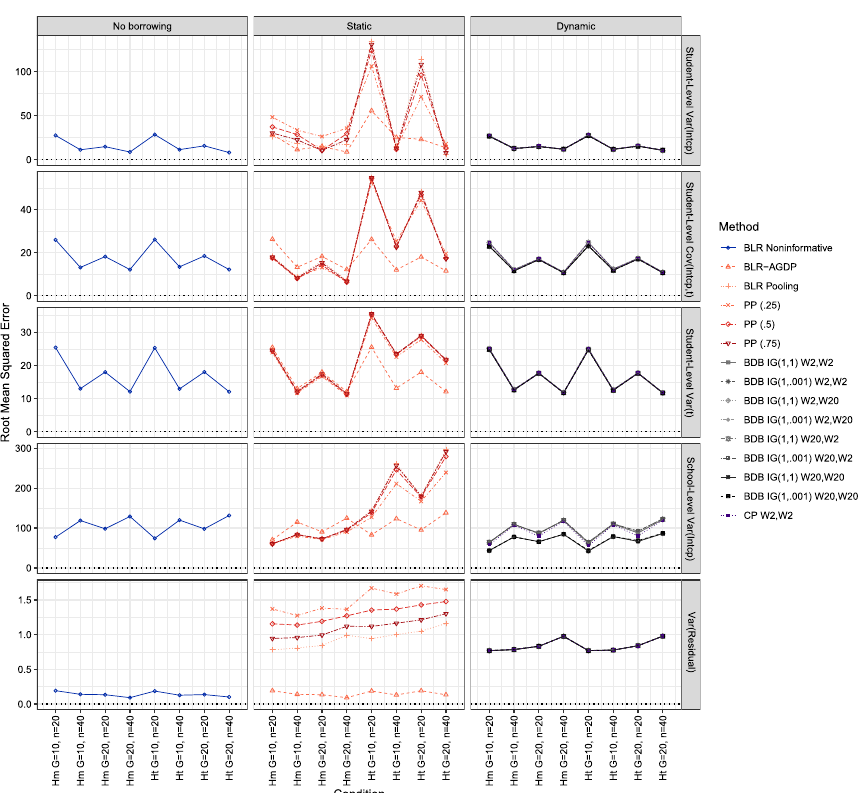
Fig. 3 Root Mean Squared Error (RMSE) of variation estimates for different sample size and heterogeneity